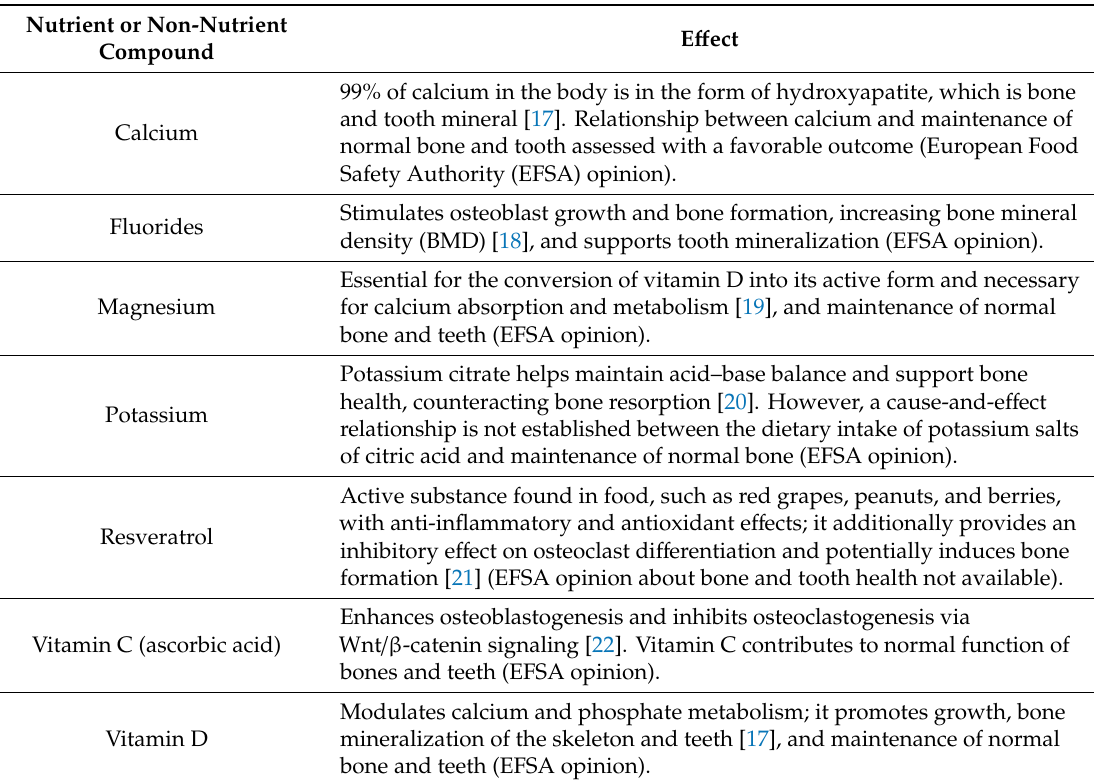
Table 1. E ff ects of selected micronutrients on bone and tooth